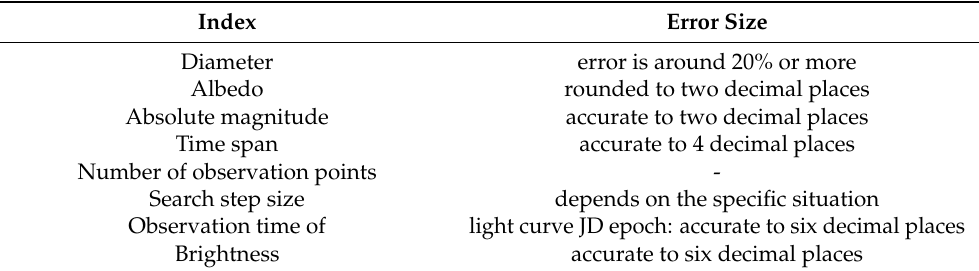
Table 8. Data error in DAMIT and LCDB